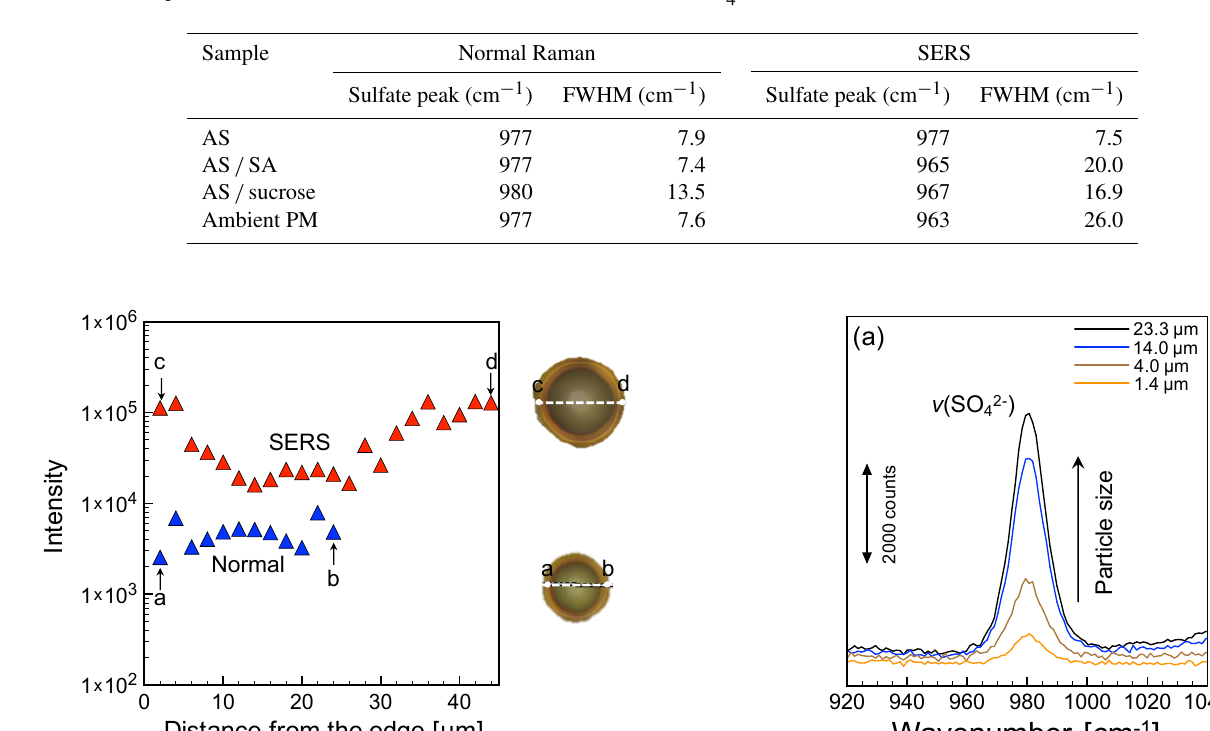
Table 2. Peak position and full width at half maximum (FWHM) at the v (SO 2 −